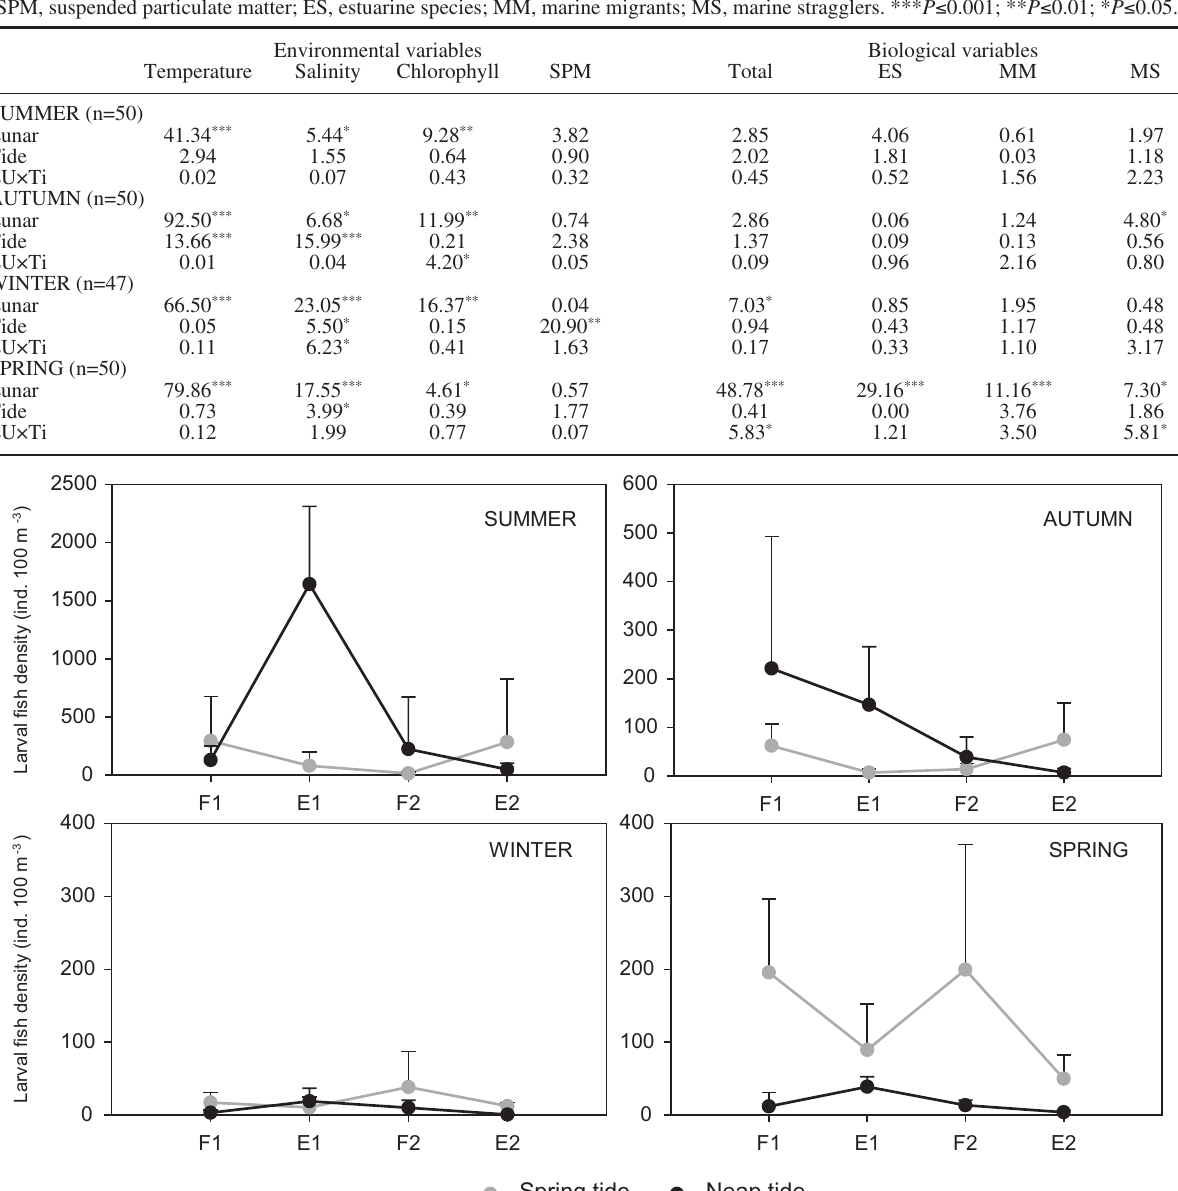
Fig. 3 . – Total larval fish densities (mean+SD, ind. 100 m -3 ) in each season and lunar-tide cycle according to tide (F, Flood; E,